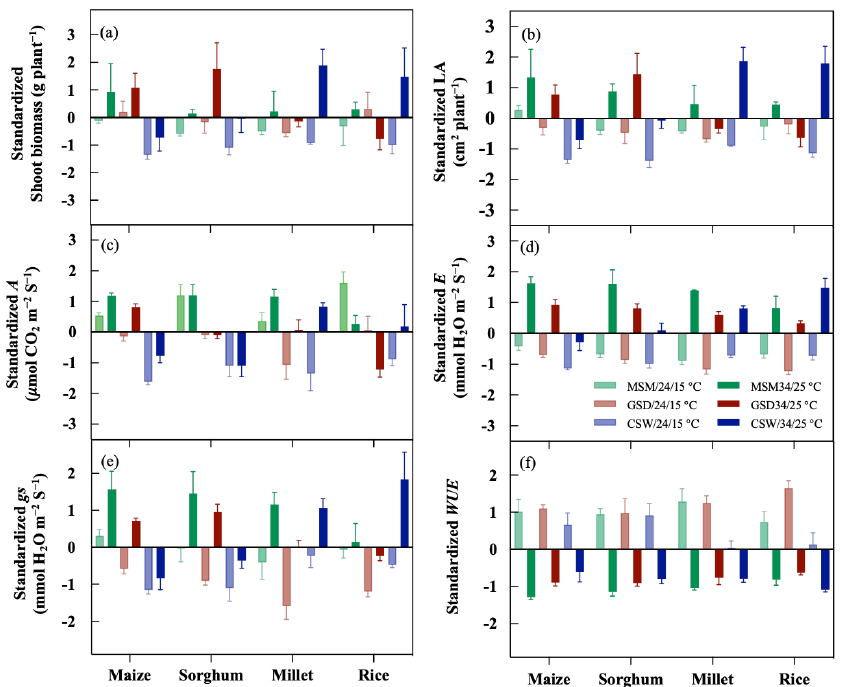
Figure 4. The responses of shoot biomass ( a ), leaf area (LA; b ), photosynthesis rate ( A ; c ), transpira- tion rate ( E ; d ), stomatal conductance ( gs ; e ), and water use efficiency ( WUE ; f ) of maize, sorghum, millet, and rice to the combination of soil moisture contents and temperatures by standardization data. The shoot biomass and LA were at 17 days after treatment, while gas exchange ( A , gs , E , and WUE ) was the average of all measurements after treatment. Bars indicate mean standard deviation. Standardization was used for transformation of data.